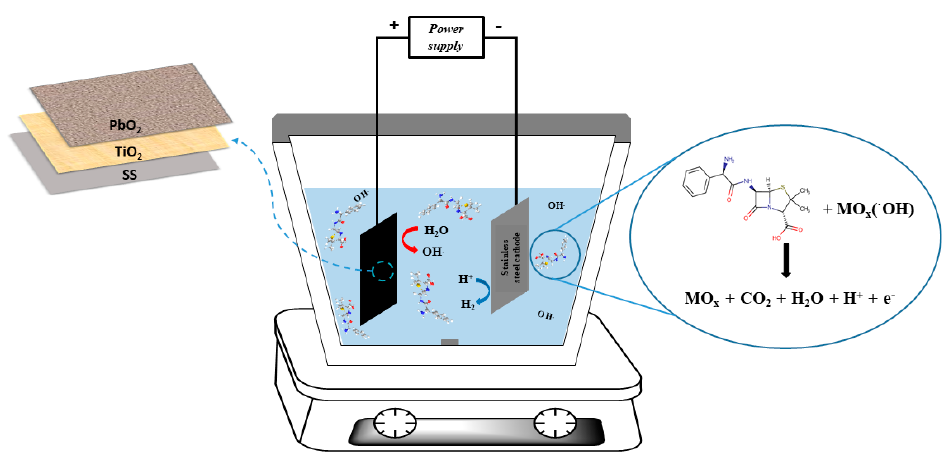
Figure 2. Schematic representation of the electrolysis experimental setup.